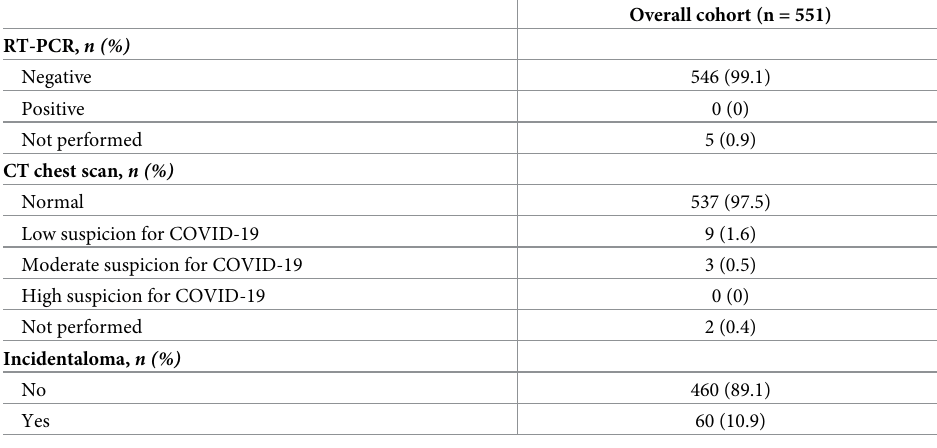
Table 2. Preoperative screening test results.